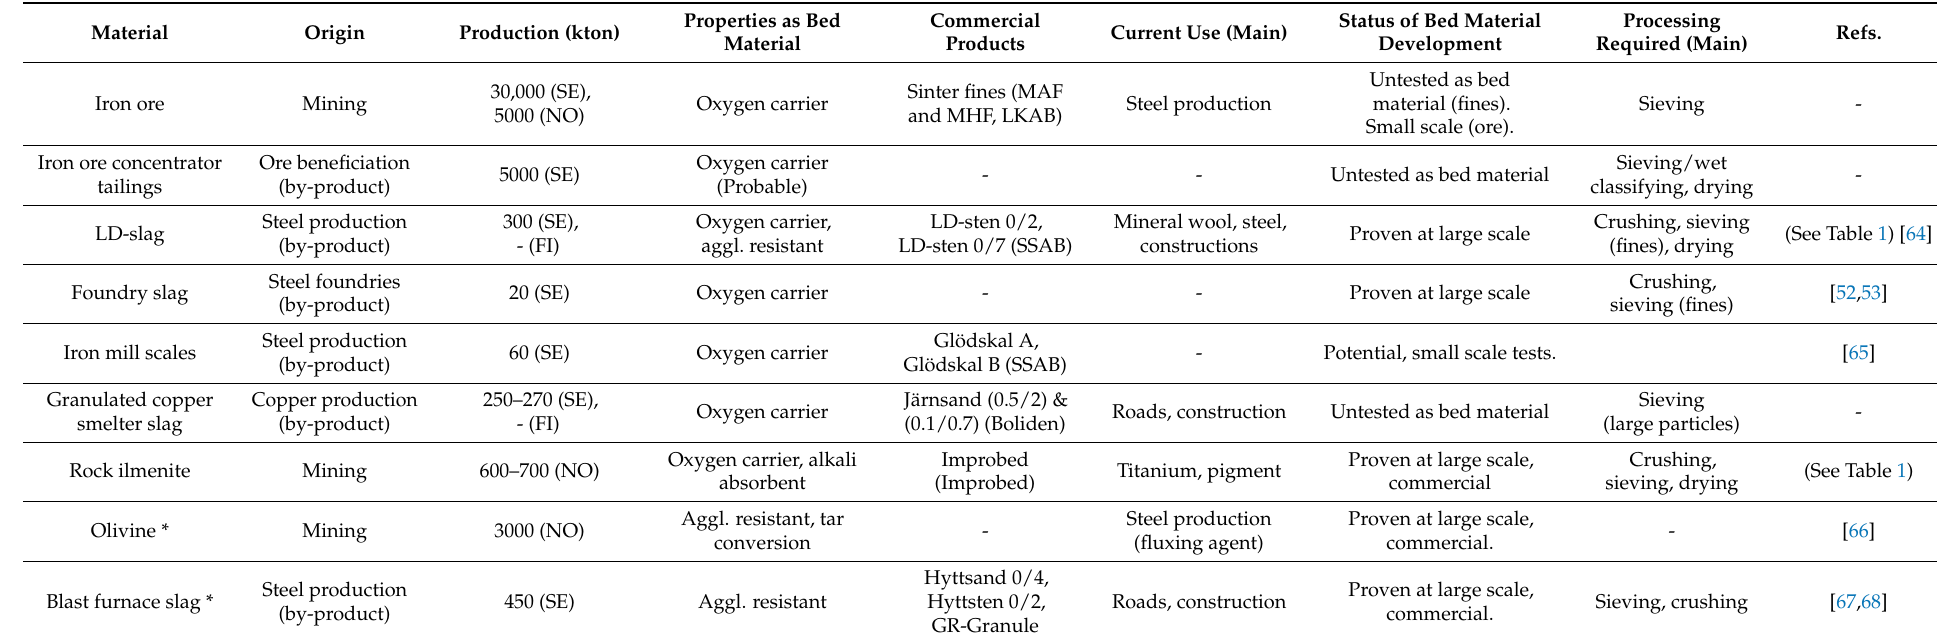
Table 3. Alternative bed materials originating from industrial production